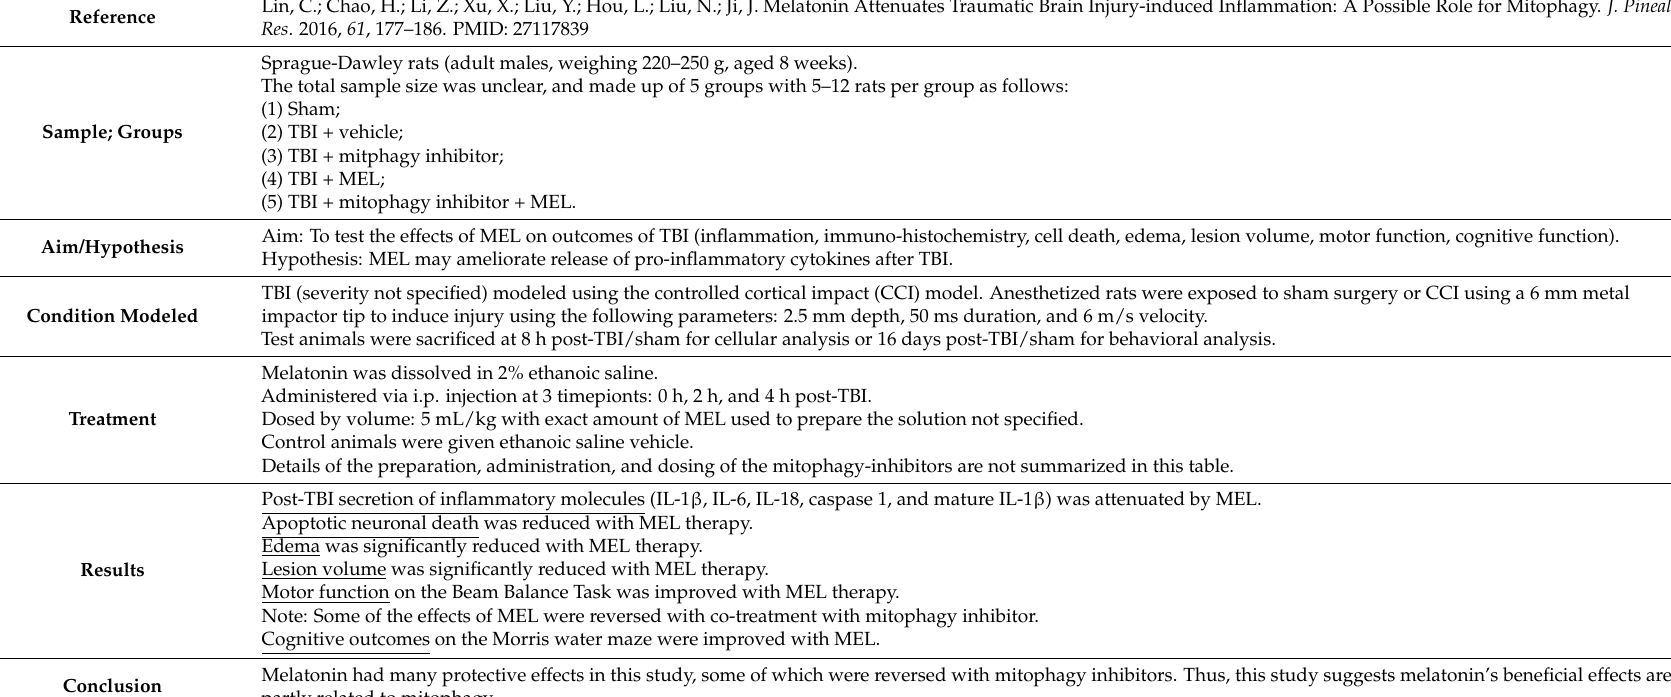
Table A20. Lin et al. (2016) Study